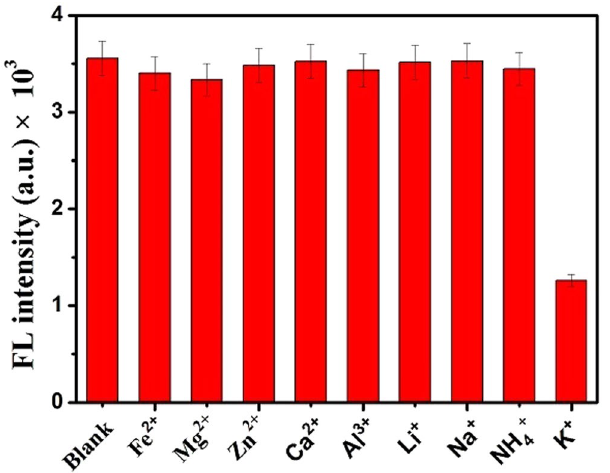
Figure 5. Response selectivity of fluorescence aptasensor toward K + ions. The concentrations of Fe 2 + , Mg 2 + , Zn 2 + , Ca 2 + , Al 3 + , Li + , Na + , NH 4 + and K + ions were 10 μ